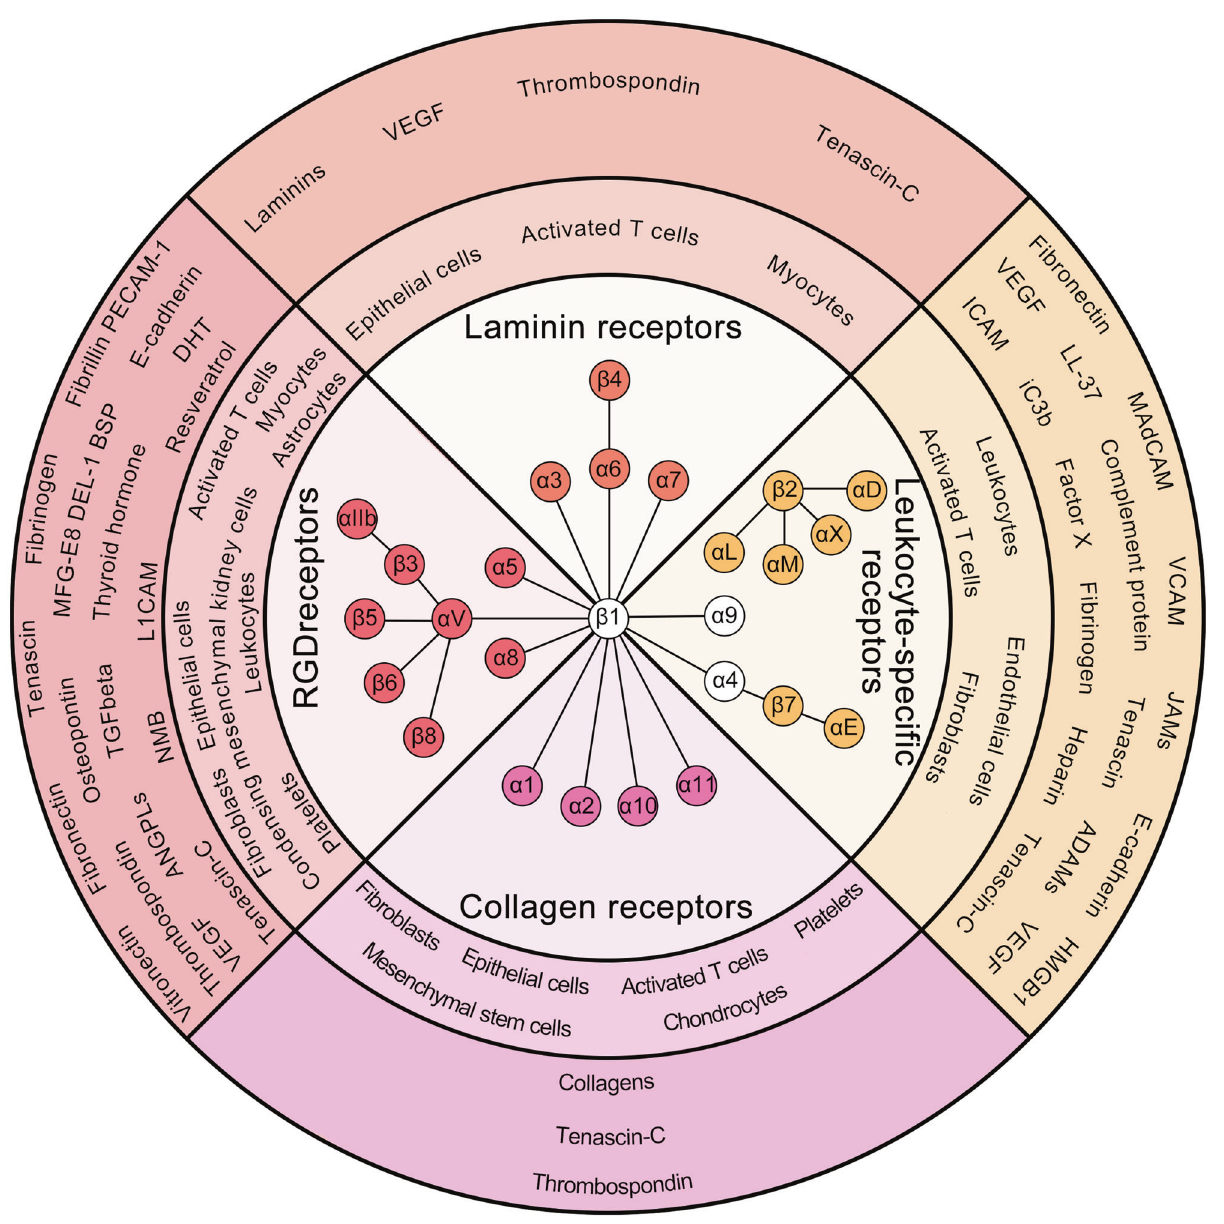
Fig. 3 Classi fi cation, distribution, and ligands of integrins. The inner ring shows the 24 integrins that are composed of 17 α subunits and 8 β subunits. They are divided into four categories, namely, RGD-binding integrins, leukocyte cell-adhesion integrins, collagen-binding integrins, and laminin-binding integrins, according to their distribution, ligand speci fi city, and functions. The middle ring shows the distribution of integrins in different cell types. The outer ring indicates the ligands bound by different types of